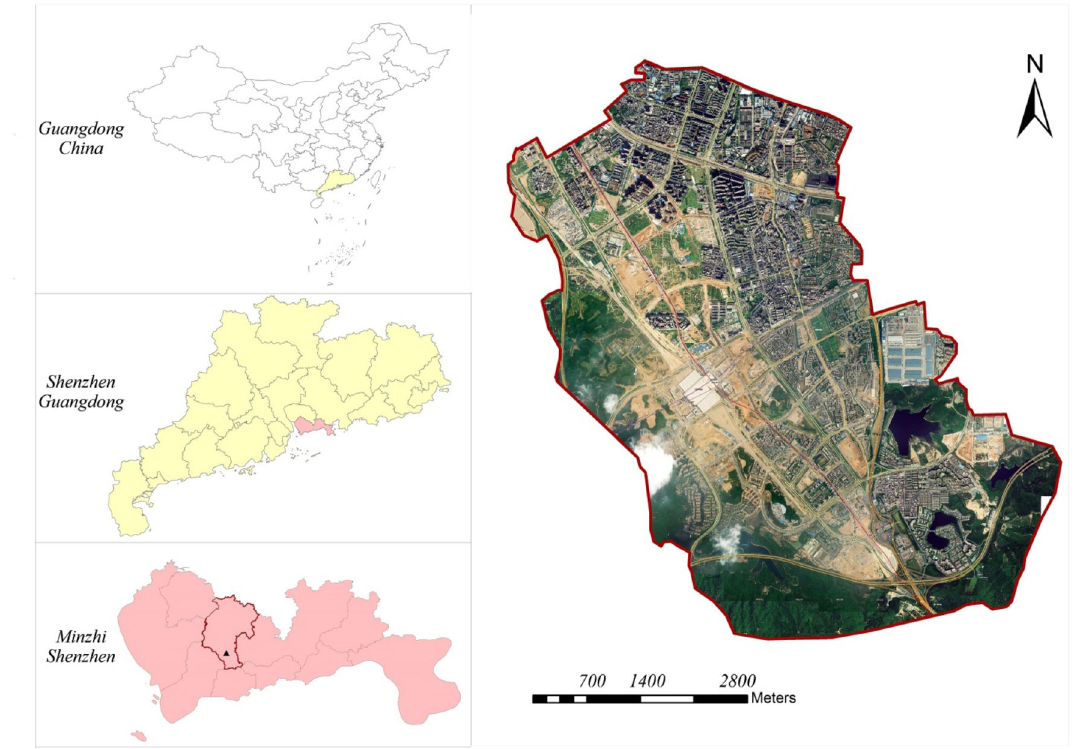
Fig. 5 Location of the study